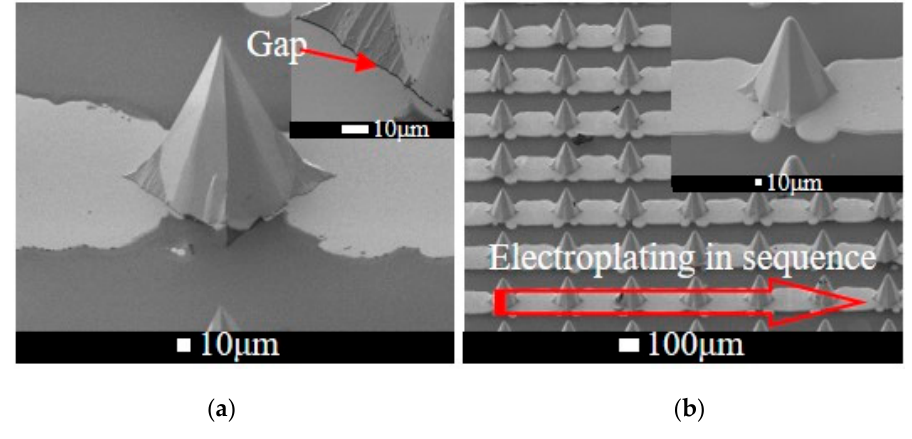
Figure 7. SEMs of microneedle arrays with ( a ) metal sputtering; ( b ) successive electroplating.